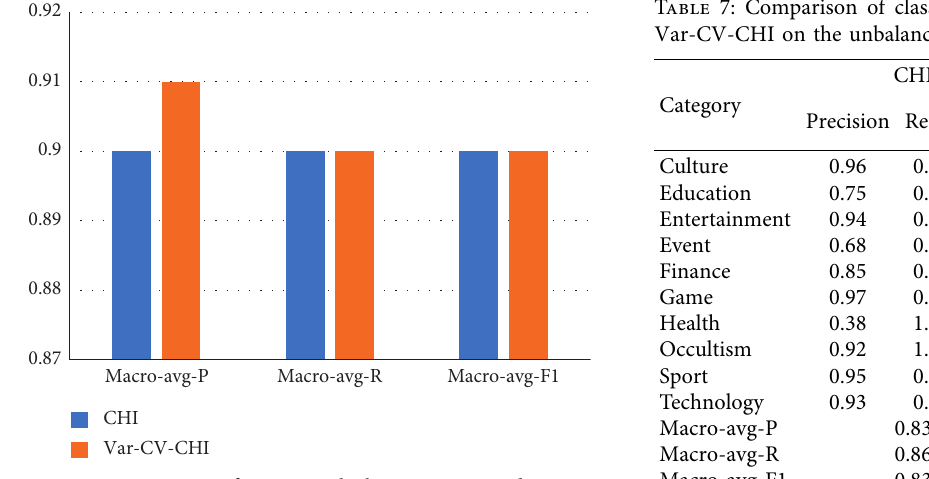
Figure 3: Comparison of macroresults between CHI and Var-CV- CHI on the balanced Chinese corpus (KNN).